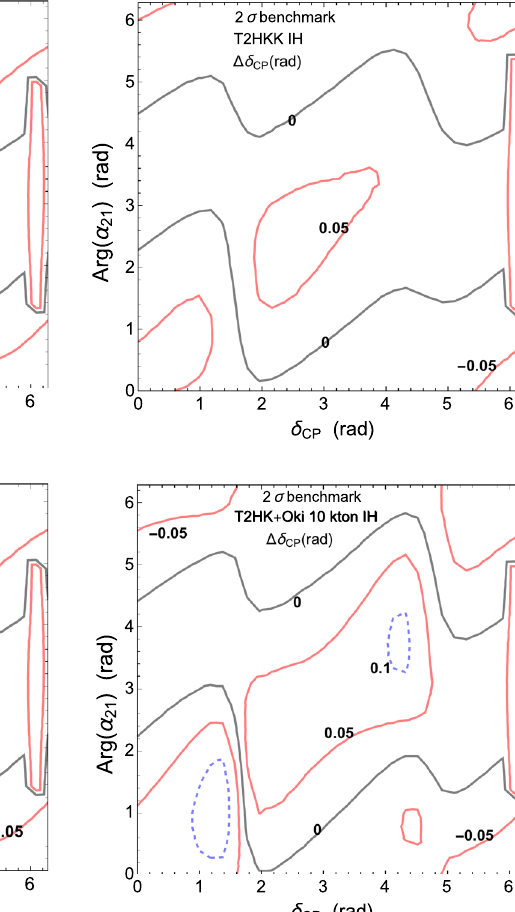
waterCerenkovdetectoratOki,respectively.Forcomparativestudy,we show in the lower-left a subplot for a plan of the T2HK plus a 10 kton water Cerenkov detector at Kamioka. | (cid:10)δ CP | = 0 , 0 . 05rad , 0 . 1rad, and 0 . 15rad on the black solid, red sold, blue dashed, and purple dot- dashed contours,